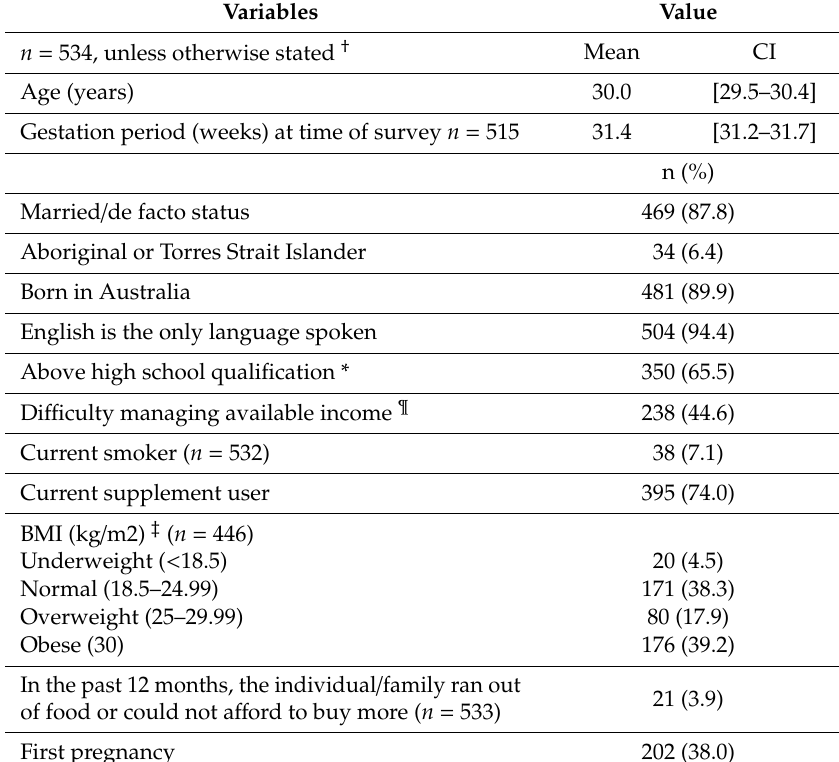
Table 1. Socio-demographic characteristics of participating pregnant women ( n =